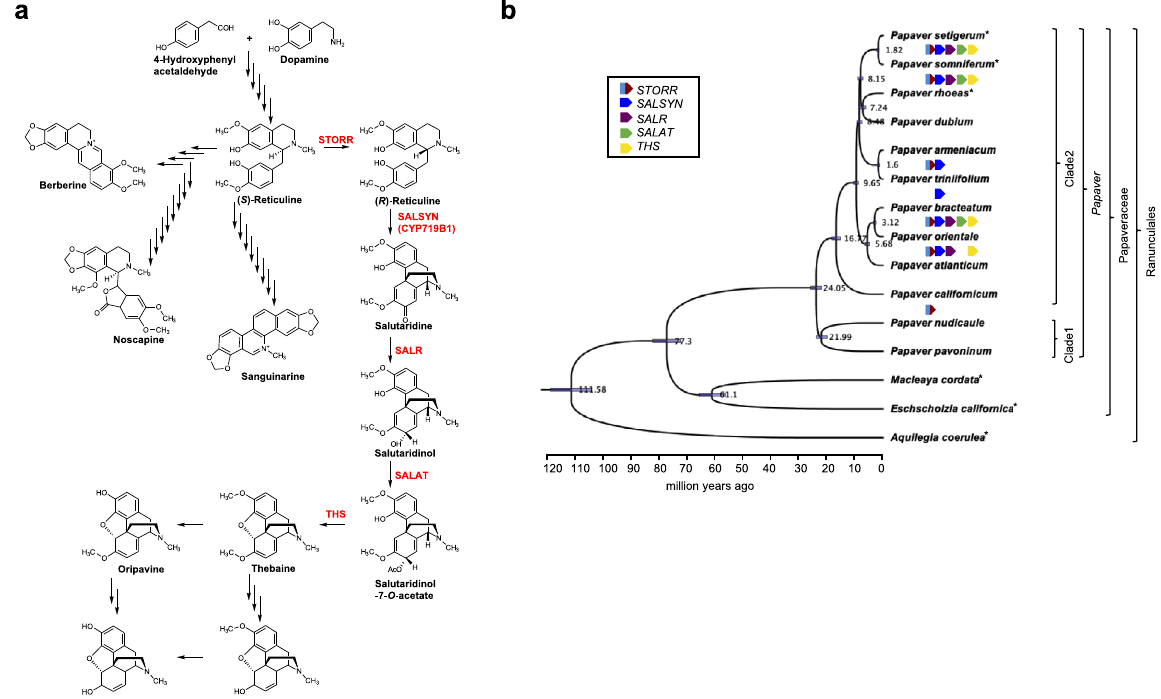
Fig. 1 Metabolite and transcriptomic analysis to investigate STORR and its distribution in Papaver species. a Schematic of the benzylisoquinoline pathway and enzymes in Opium Poppy with a focus on morphinan production. ( S )-reticuline is the central branch point of BIA metabolism in opium poppy for the production of structurally distinct compounds including the morphinans plus noscapine, berberine and sanguinarine. Conversion of ( S )- to ( R )- reticuline by STORR represents the fi rst committed step in biosynthesis of the promorphinans (salutaridine, Salutaridinol and salutaridinol-7- O- acetate) and morphinans (thebaine, oripavine, codeine and morphine). Compound names are in black and enzymes speci fi c to the promorphinan and morphinan pathway are in red. b Species phylogeny inferred by Bayesian inference species tree using eight single copy conserved ortholog sequences. Phylogeny and divergence dates are estimated using BEAST2, which are shown on the nodes. Light-blue bars at the nodes indicate the range with 95% highest posterior density. Taxonomy groupings of the species are indicated and the twelve Papaver species are placed into two different clades (Clade 1 and Clade 2) as described by Carolan et al. 20 . Species highlighted with an asterisk indicate all gene sequences were identi fi ed and retrieved from the corresponding annotated genomes whereas for the remaining nine Papaver species, transcriptomic datasets were used. Presence of the STORR and the four promorphinan genes are shown under species names (Supplementary Data 2). Source data are provided as a Source Data fi